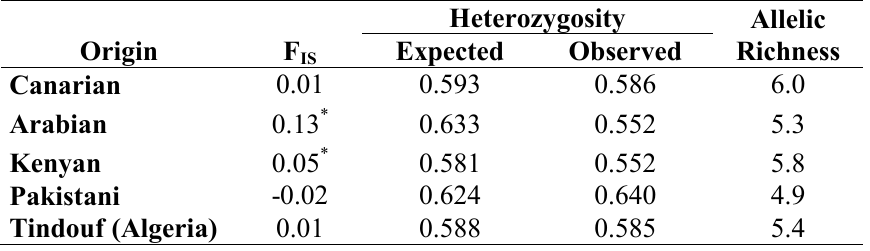
Table 2. Inbreeding rate in terms of F , expected and observed heterozygosities, and allelic IS richness (based on minimum sample size of 28 animals) computed by geographical origin of the populations.